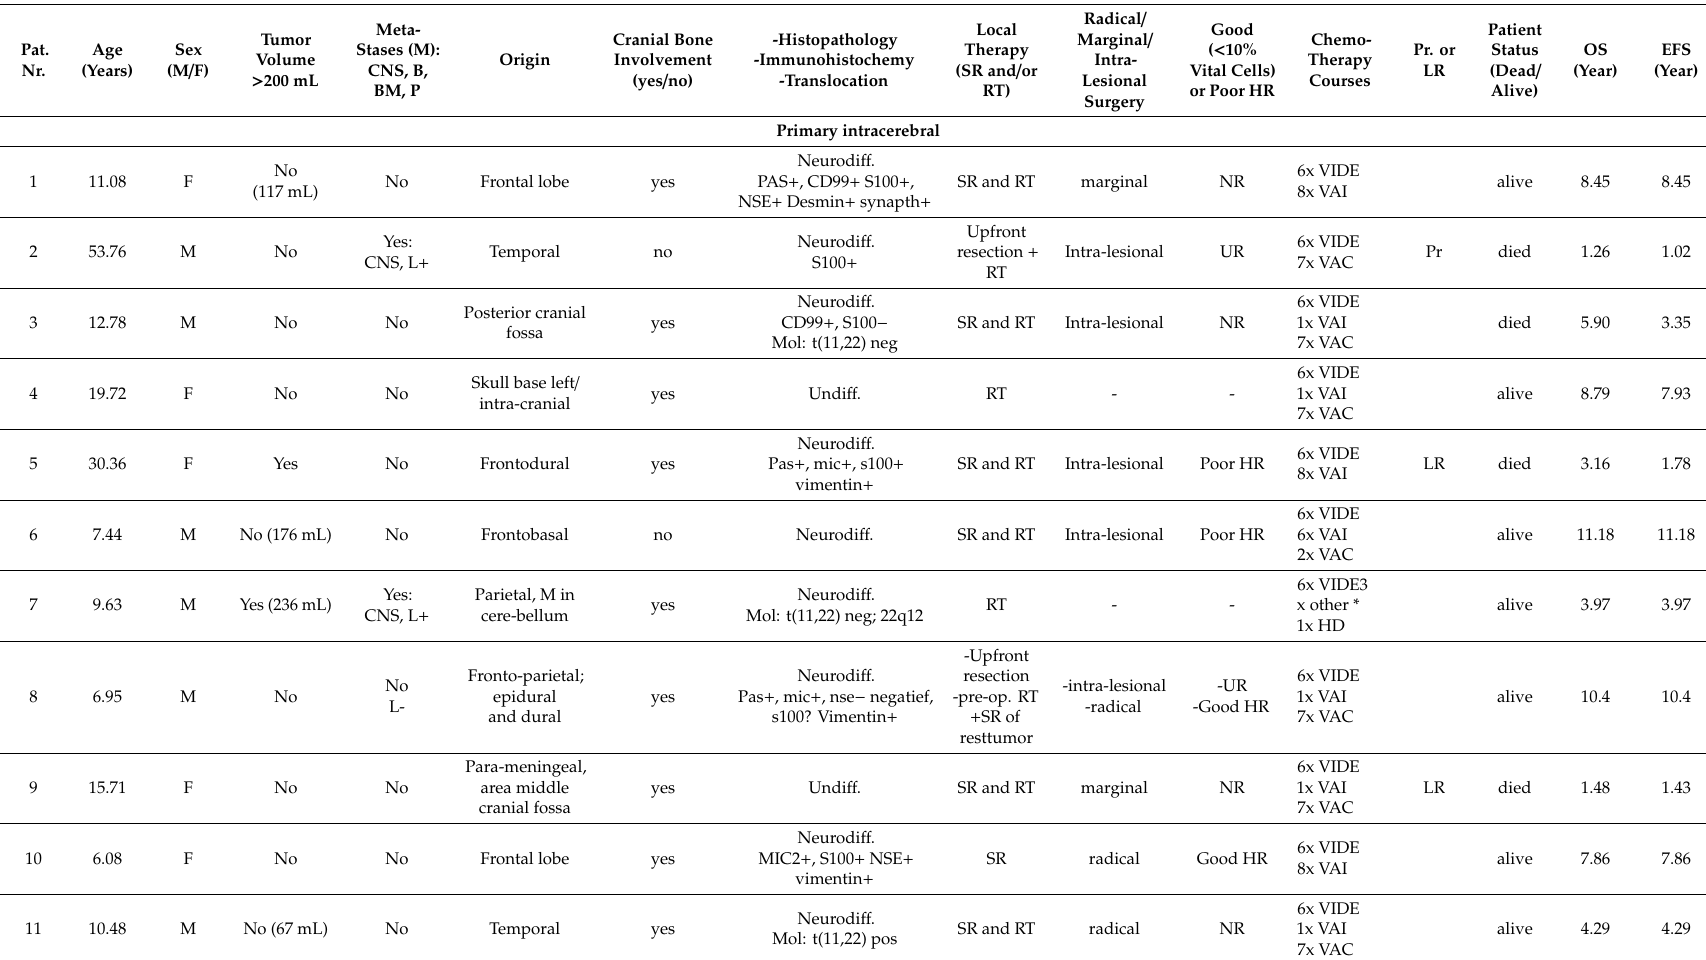
Table 1. Baseline characteristics and treatment modalities of included patients with primary and metastatic intracranial Ewing sarcoma.